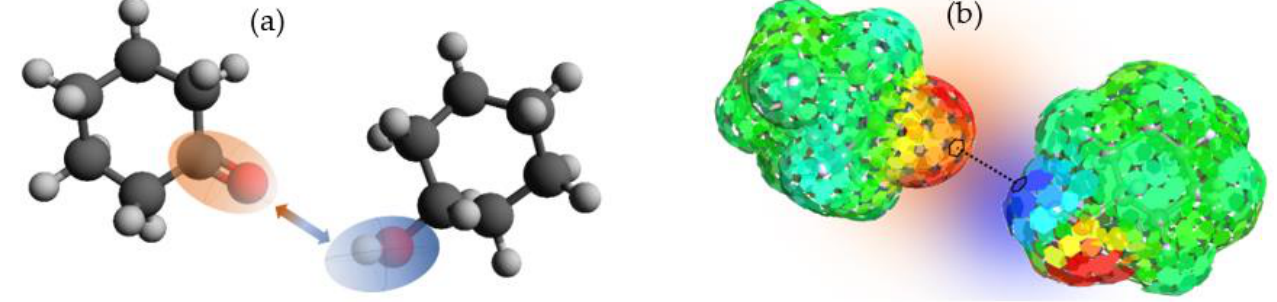
Figure 3. ( a ) Interaction between functional groups that give rise to the mixing effects following the GCM, UNIFAC. ( b ) Interaction of hexagonal surface elements that generate μ S by means of the COSMO-RS